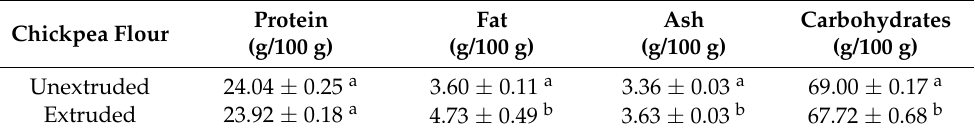
Protein (g/100 g)